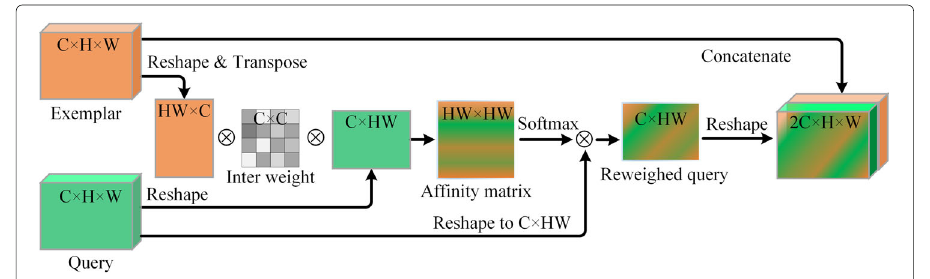
Fig. 4 Architecture of the proposed